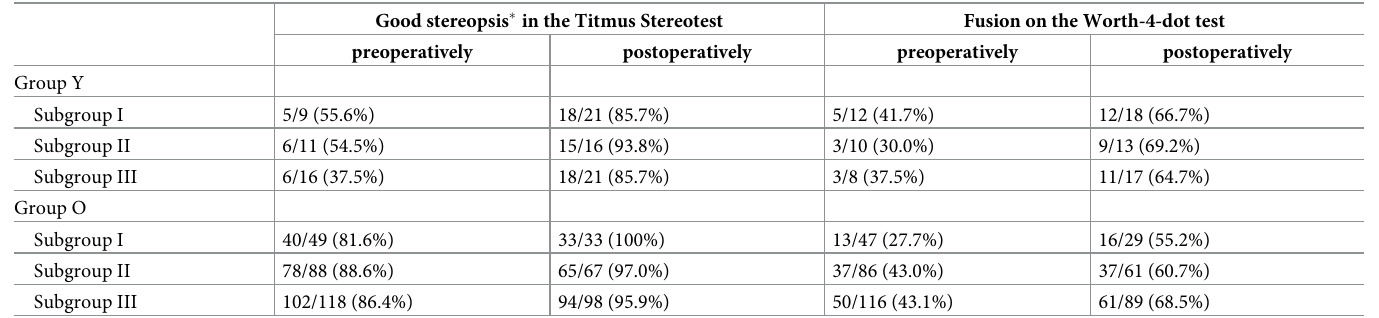
Table 6. Preoperative and postoperative sensory status measurements by the Titmus and Worth-4-dot tests. Good stereopsis � in the Titmus